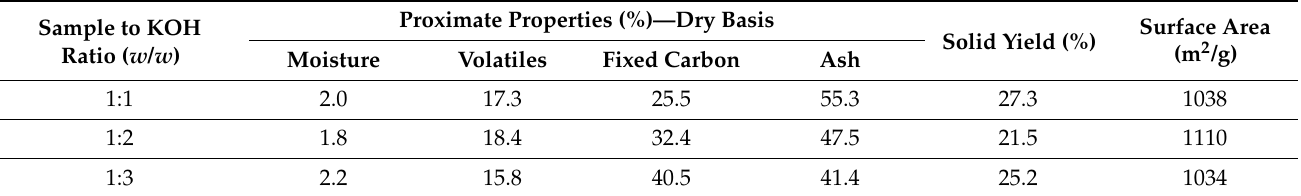
Table 5. The proximate analysis, yield, and surface area of CM-DTC.